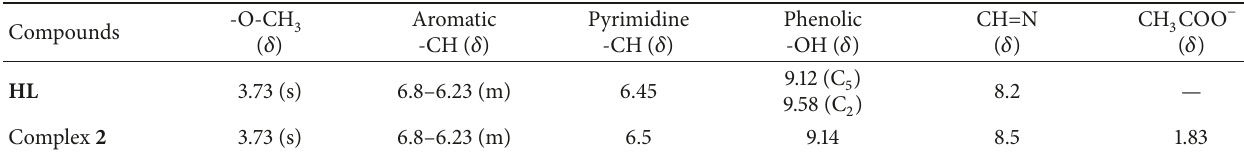
Table 2: 1 H-NMR spectral data of the ligand HL and complex 2 .